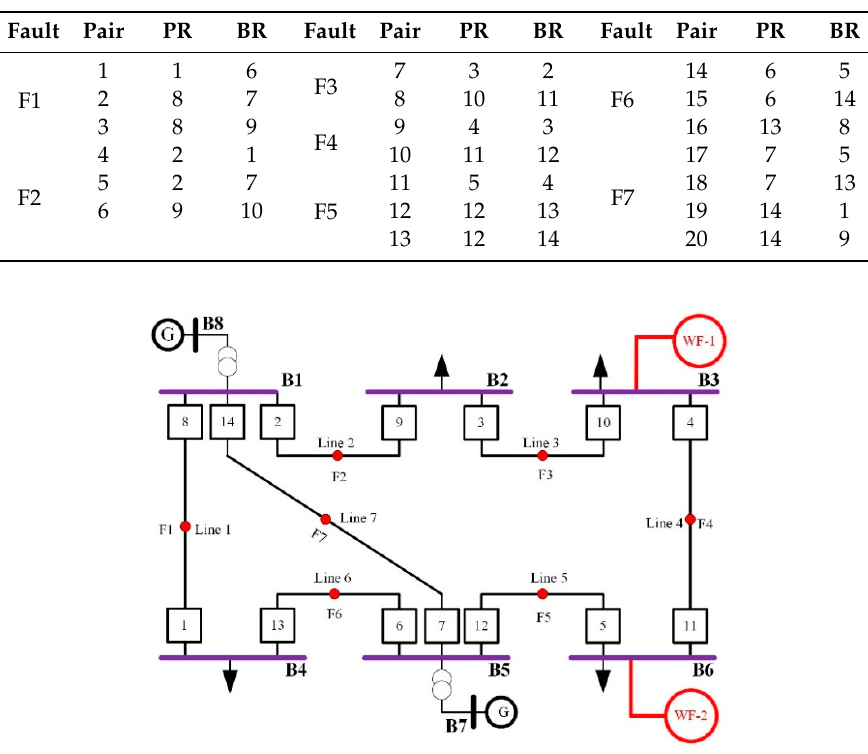
Table 3. Primary (PR) and backup (BR) relay pairs for the IEEE-8 bus system.